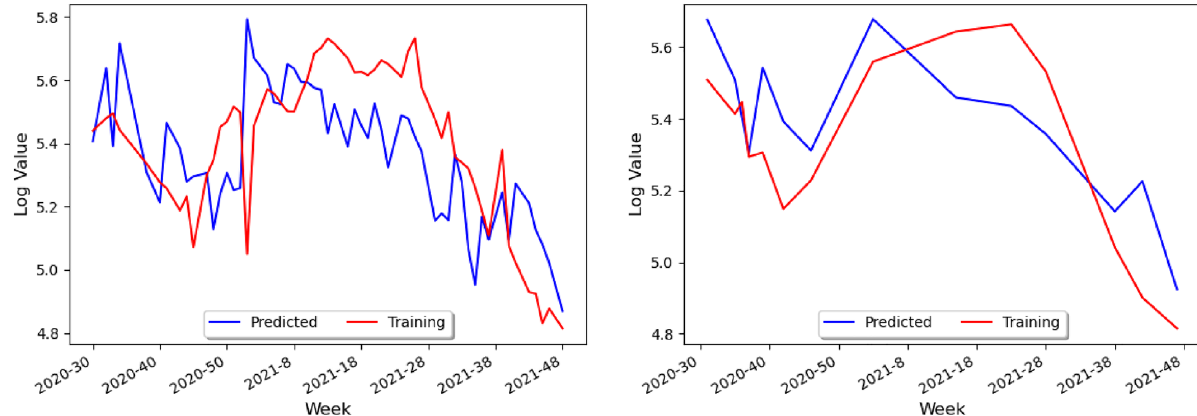
Figure 11. Actual data and predicted data for only climate on the training set (left) and the test set